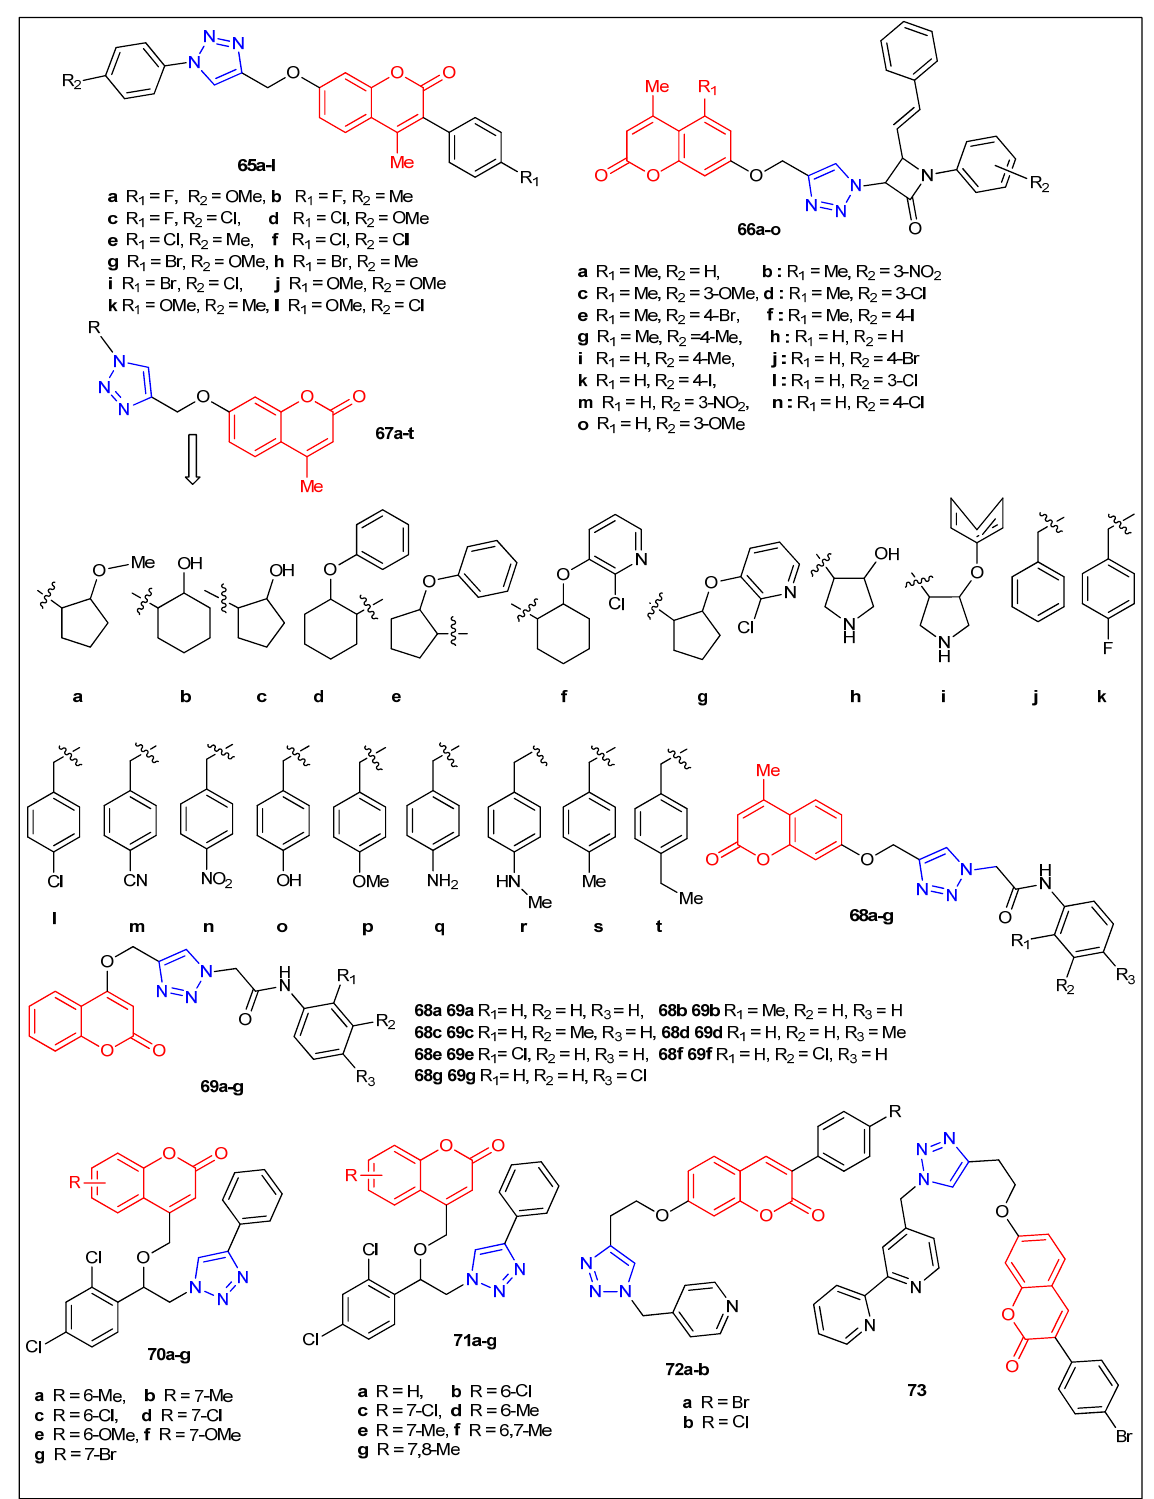
Figure 8. Structures of the reported coumarin triazole derivatives from 2020 – 2021 . Synthesis of new hybrids of 3-(1,2,3)-trazolyl-coumarin derivatives [ 78a – w ] (Figure 9) was reported by Kraljevic et al. [64]. All hybrids of 3-(1,2,3)-trazolyl-coumarin deriva- tives [ 78a – w ] were tested toward Gram-positive S. aureus , S. aureus MRSA, E. faecali , E. faecium VRE, and Gram-negative E. coli , K. pneumoniae , K. pneumoniae ESBL, P. and A. bau- mannii . Undesirably, all 3-(1,2,3)-trazolyl-coumarin derivatives [ 78a – w ] had MICs higher